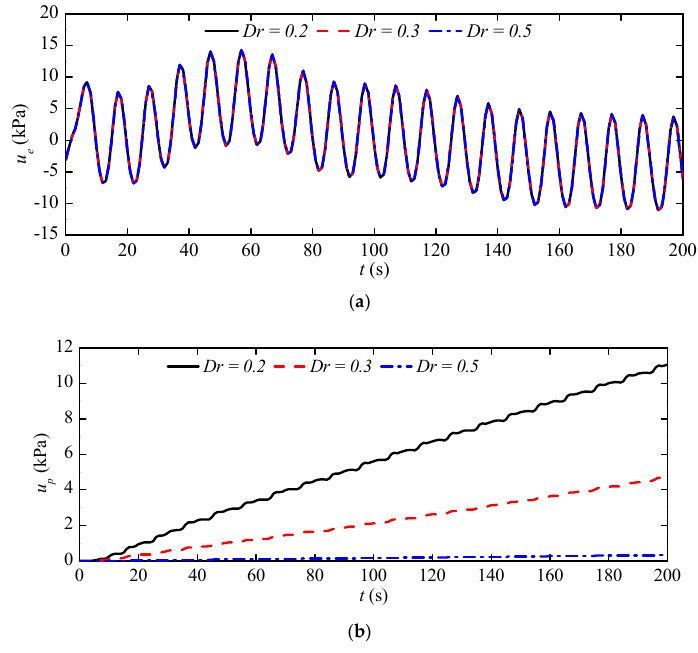
Figure 6. Variation of ( a ) oscillatory pore pressure, 𝑢 (cid:3032) and ( b ) residual pore pressure, 𝑢 (cid:3043) _p at a Figure 7. Variation of ( a ) oscillatory pore pressure, u e and ( b ) residual pore pressure, u p _p at a specific specific point under the different relative density. point under the different relative